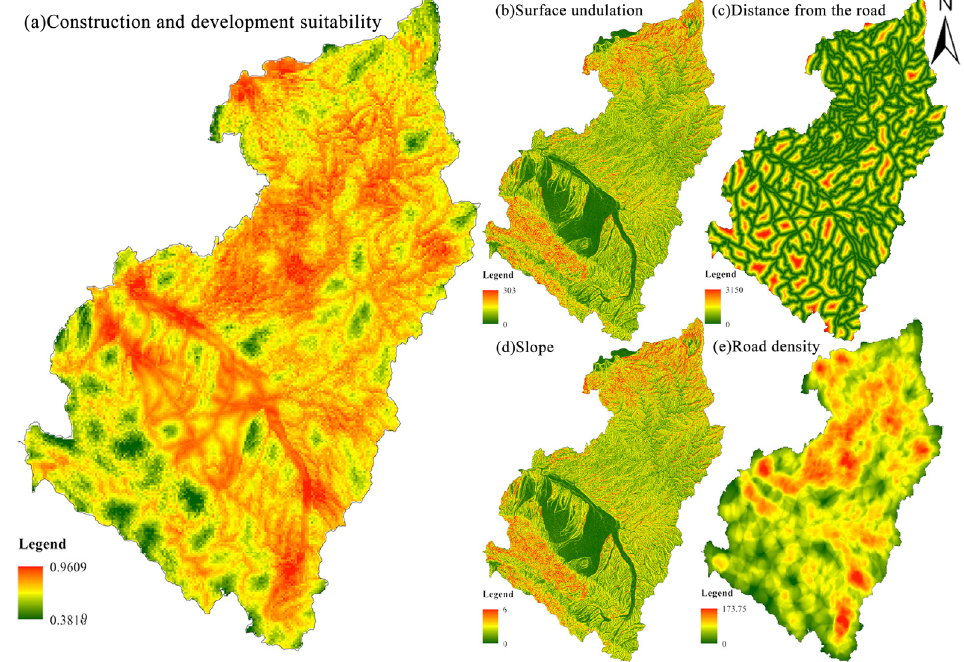
Figure 8. The spatial distribution of the construction and development suitability.